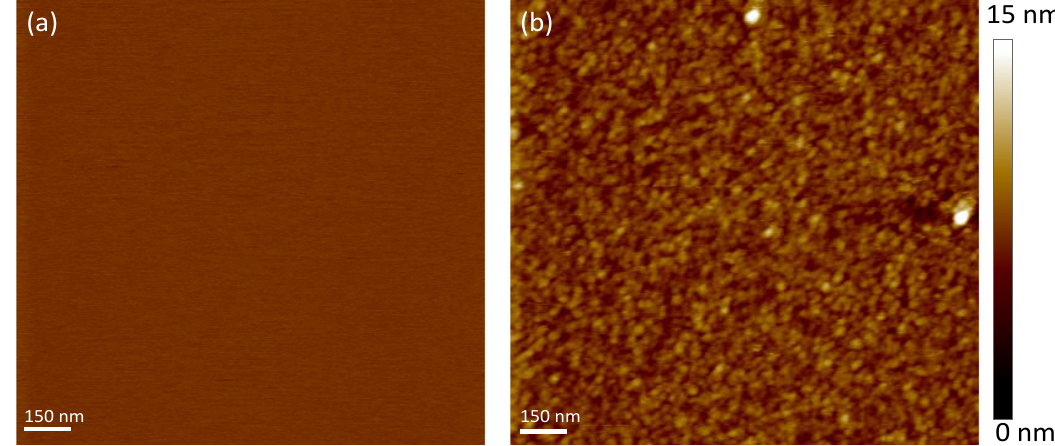
Figure 4. Atomic force microscopy (AFM) topography of ( a ) unmodified and ( b ) polydopamine-coated mica in water using tapping mode (scan size 1.5 µm × 1.5 µm). Z -scale is shown on the right